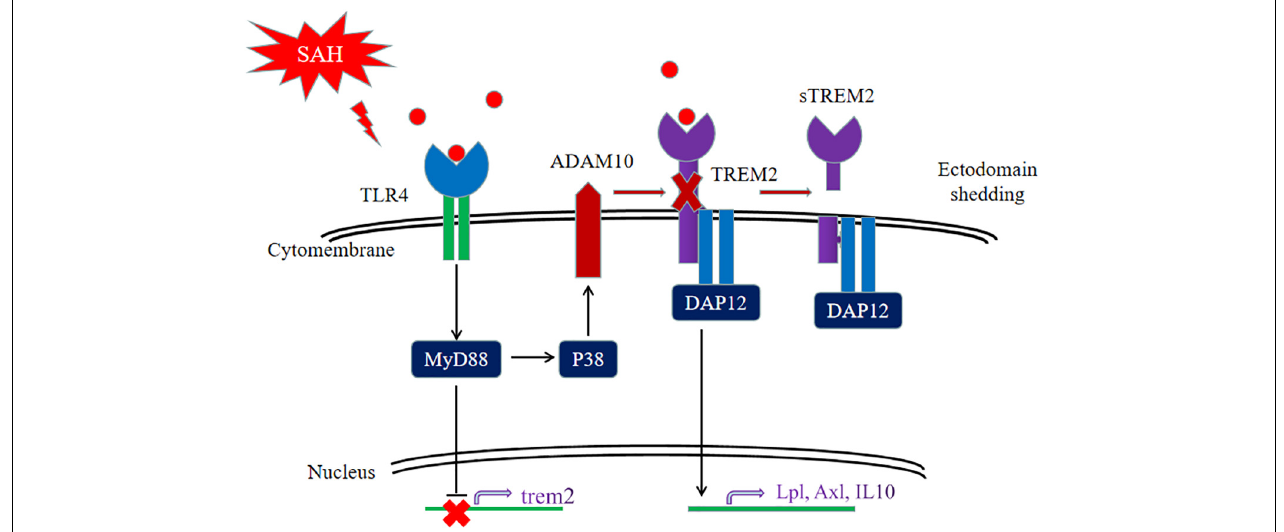
FIGURE 11 | Schematic model of the interplay between triggering receptor expressed on myeloid cells 2 ( TREM2 ) and Toll-like receptor 4 ( TLR4 )-induced inflammation after subarachnoid hemorrhage (SAH). The TLR4 -induced inflammation suppresses the TREM2 signaling pathway to exacerbate SAH-triggered inflammatory response in microglia. After SAH onset, the activated TLR4 pathway can interfere TREM2 by inhibiting the increment of TREM2 expression and cleaving TREM2 into a secreted form.